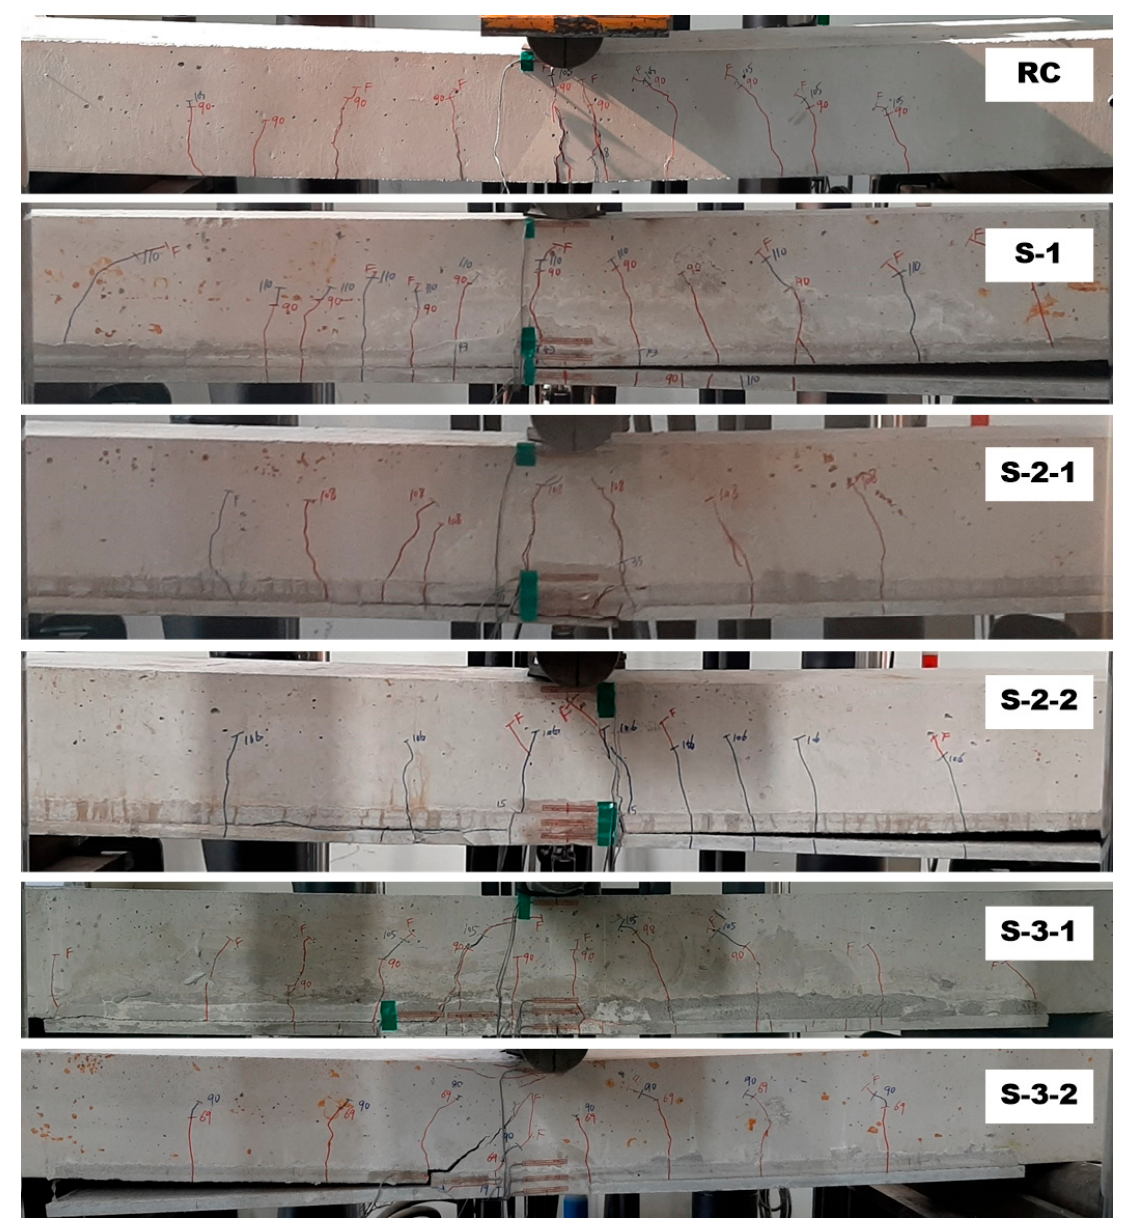
Figure 16. Side view of slab specimens after failure test.